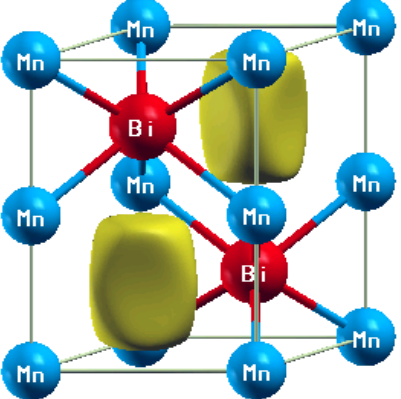
Figure 7. Yellow boxes indicate the low electron density areas of the hexagonal LTP MnBi